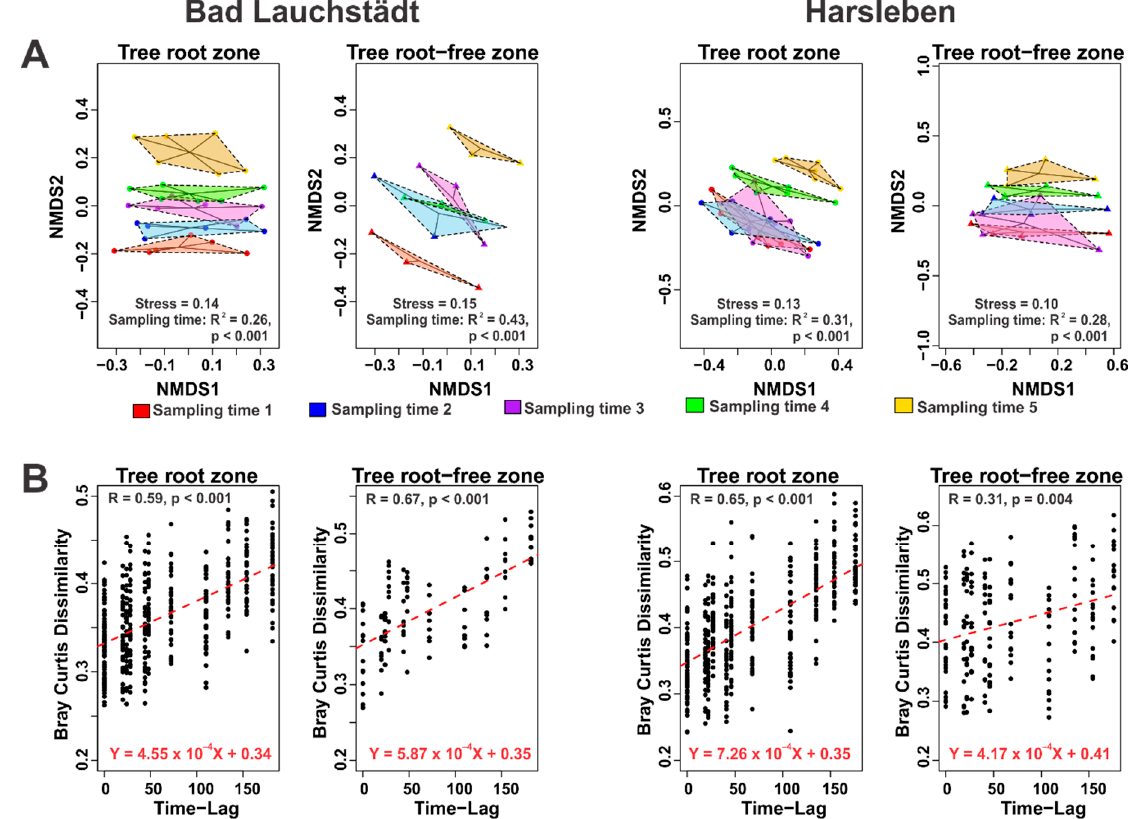
Figure 1. ( A ) Non-metric multidimensional scaling (NMDS) based on Bray–Curtis dissimilarity displaying bacterial community structure along with succession of sampling times. R 2 and p values are PERMANOVA results showing the effect of sampling time points, which coincided with ends of the tree RF1, SF1, RF2, SF2, and the senescence. ( B ) Correlation between distance in time along vegetation period and Bray–Curtis dissimilarity among the bacterial communities. R and p values are Mantel correlation test results. Time-Lag here means number of days in-between sampling